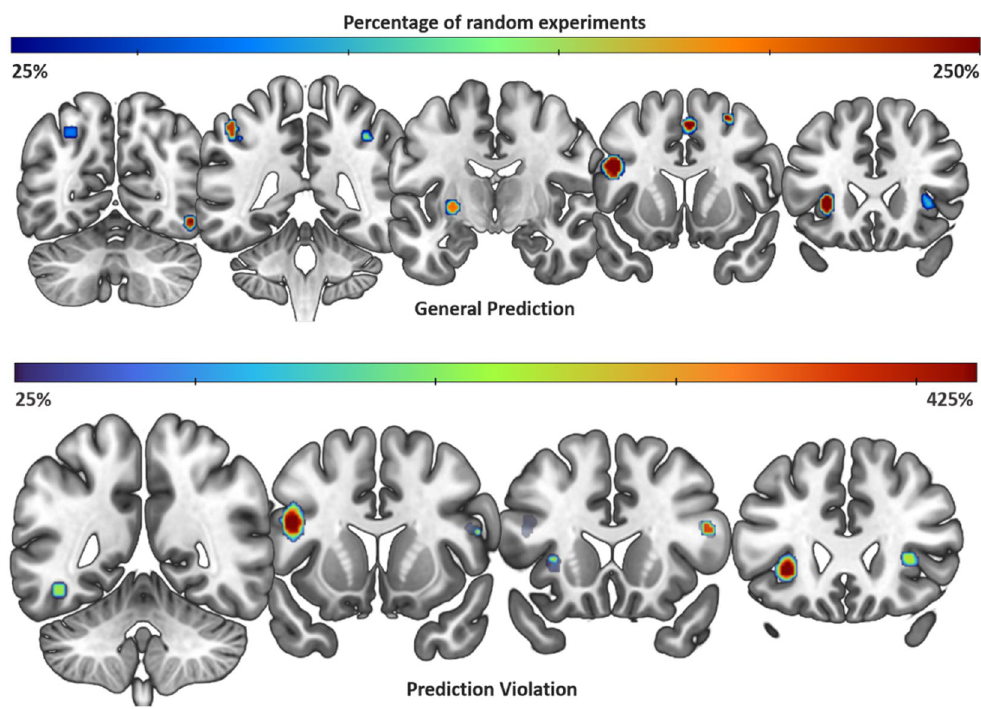
Figure 5. Coronal sections showing the results of the fail-safe analysis. Upper row: General Prediction; lower row: Prediction Violation. The color scales represent gradually increasing added random data in percentage. The warmer the color of the pixels, the more random noise (representing potentially unpublished results) is